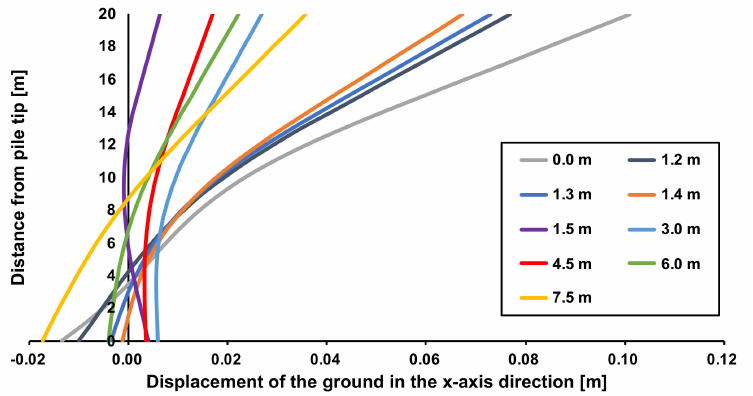
Figure 14. Displacements of new pile when installing position is shifted by +1.2 m or